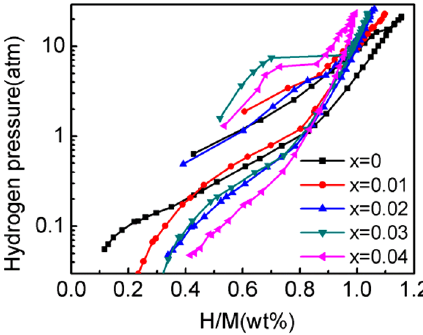
Fig. 4 P–C–T curves of the